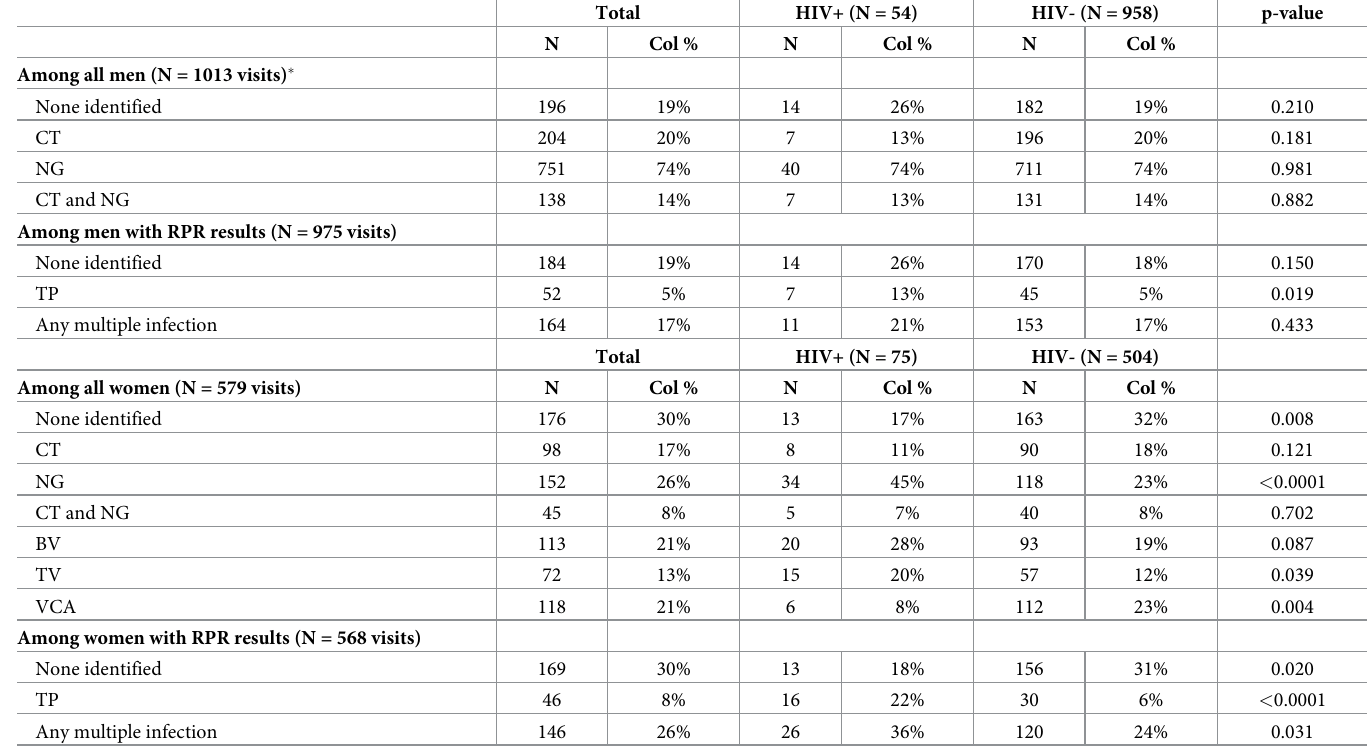
Table 1. Distribution of pathogens identified in symptomatic men and women in Kigali,